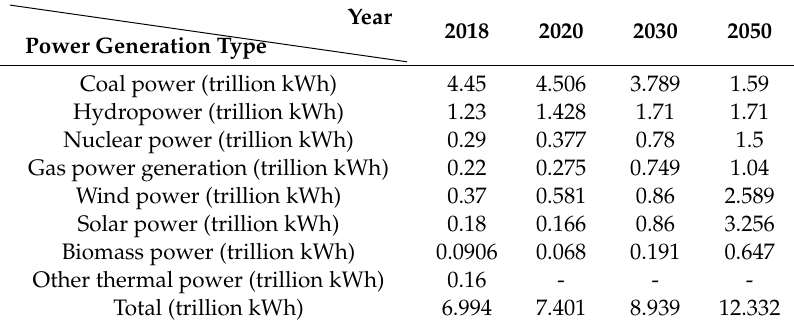
Table A2. China’s power structure data in 2018, 2020, 2030, and